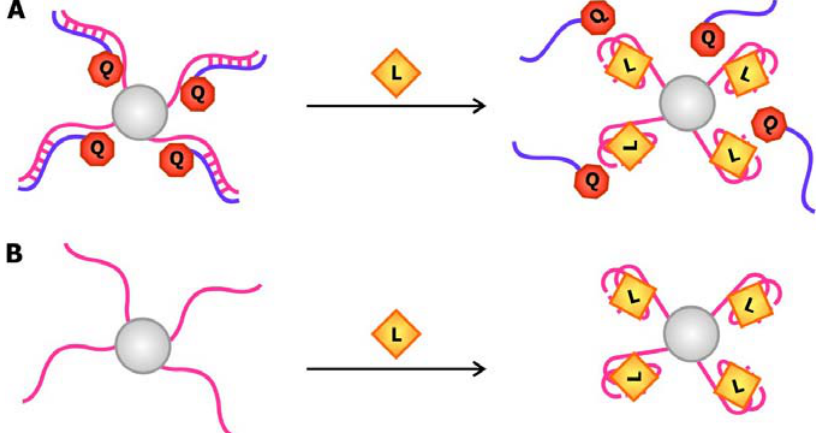
Figure 7. Quantum dot (QD)-based biosensors. a) The FRET-based QD aptamer biosensor by the Ellington group [55]. b) In the QD-based biosensor by Choi and colleagues [56], quenching of its